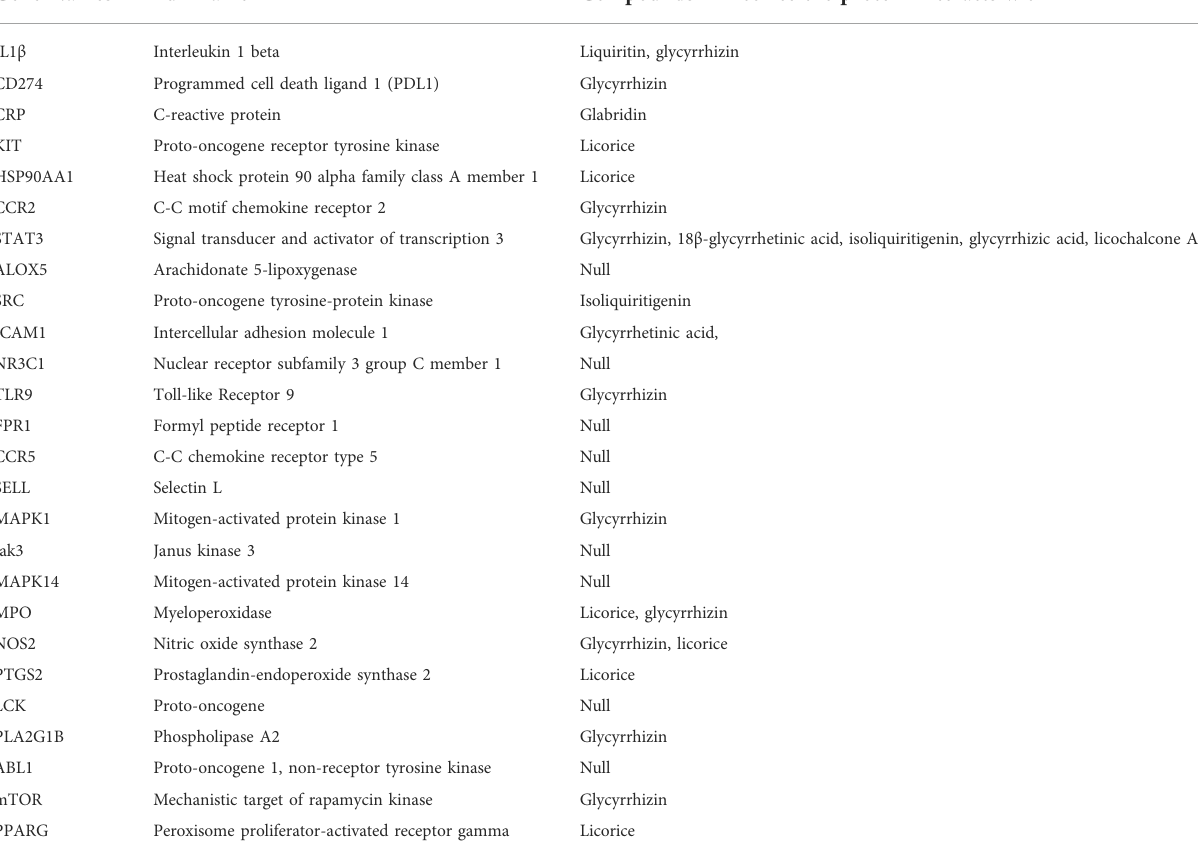
TABLE 2 Proteins Interacting with Ingredients in